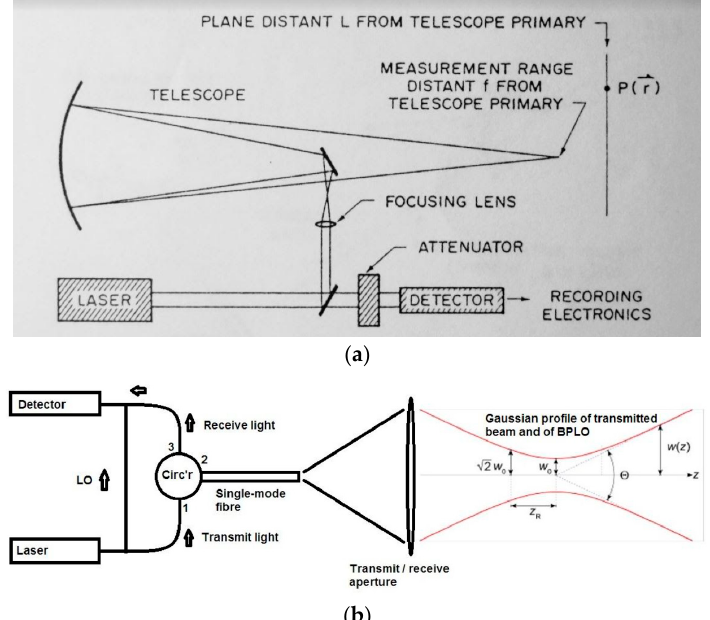
Figure 1. Schematics of laser Doppler systems for remote wind sensing. ( a ) Reproduced from Lawrence et al. [3] (“A laser velocimeter for remote wind sensing”, Rev. Sci. Instrum. 1972, vol. 43, pp.